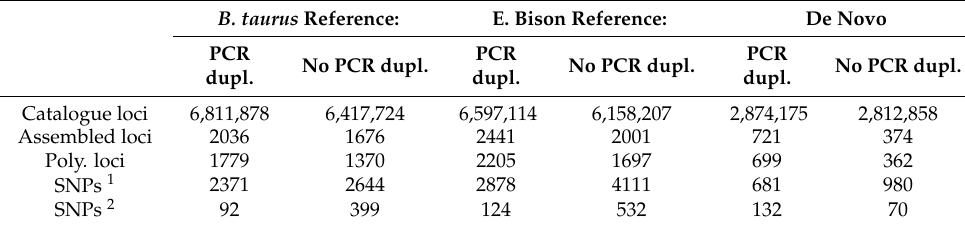
Table 1. Comparison of obtained numbers of catalogue loci, assembled loci, polymorphic loci, and SNPs using two different approaches: reference pipeline (for Bos taurus (B. taurus) and European bison (E. bison) and de novo pipelines, with and without PCR duplicates (PCR dupl. and no PCR dupl.)). B. taurus